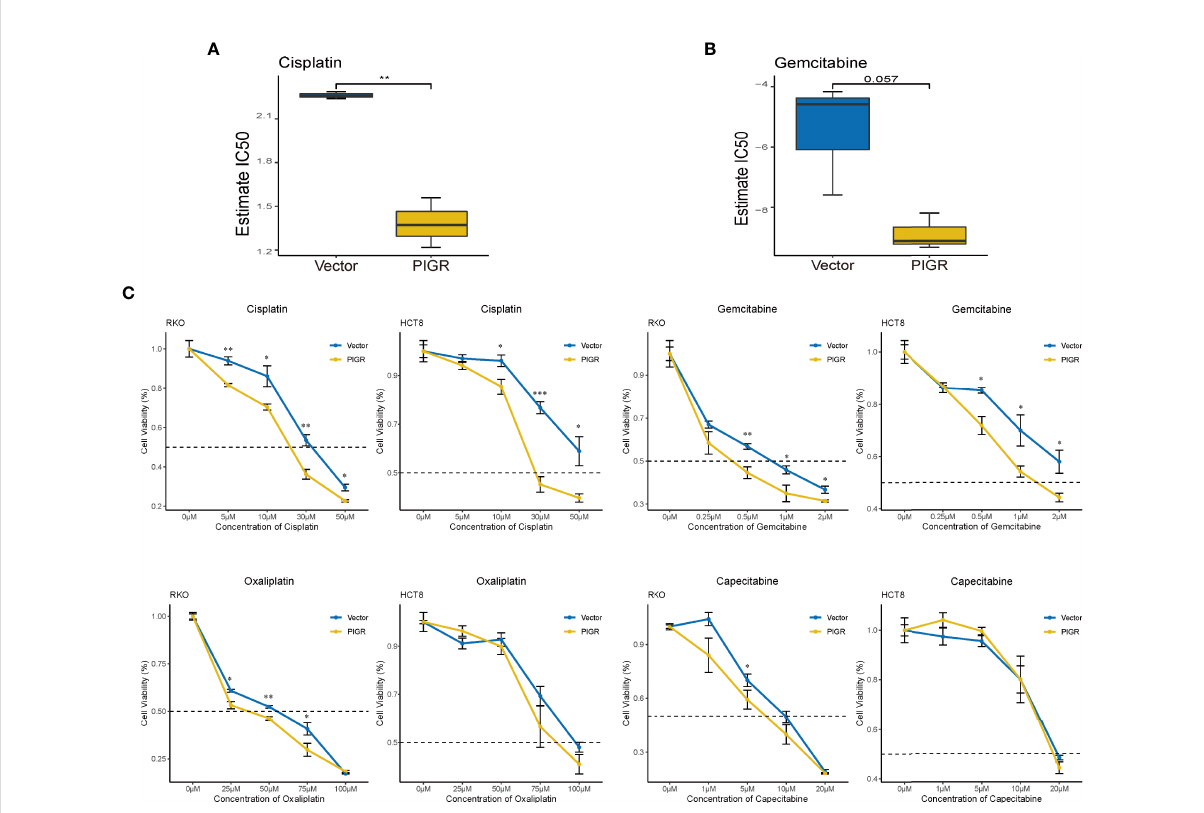
FIGURE 7 PIGR overexpression increases chemotherapy sensitivity in CRC cells (A, B) Estimated IC50 of cisplatin (A) and gemcitabine (B) in RKO and PIGR overexpression RKO cells. (C) Cell viability after treated with a series concentration of cisplatin, gemcitabine, oxaliplatin and capecitabine of RKO and HCT-8 cells. * P < 0.05; ** P < 0.01; *** P <